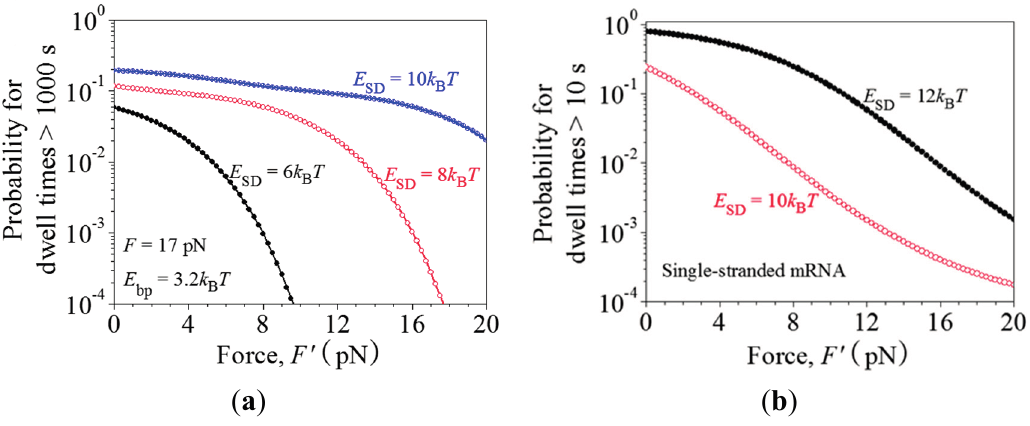
Figure 7. Ribosomal arrest or pausing caused by the interaction of the SD sequence with the anti-SD site of the 30S subunit can be rescued by external force F ′ applied to the 30S subunit. ( a ) Probability of arrest (>1000 s) vs. force F ′ for the ribosome translation through the mRNA duplex with different values of the binding energy between SD and anti-SD, E SD . F = 17 pN and E bp = 3.2 k B T ; ( b ) Probability of pausing (>10 s) vs. force F ′ for the ribosome translation through the single-stranded mRNA with different values of E SD